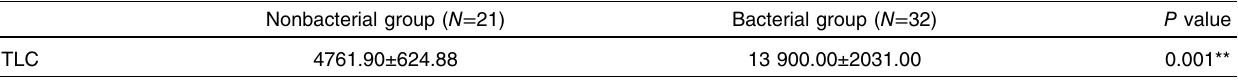
Table 11 Comparison between mean values of TLC in the two studied groups Nonbacterial group ( N = 21) Bacterial group ( N = 32) P value TLC 4761.90±624.88 13 900.00±2031.00 0.001** TLC, total leukocyte count. ** P < 0.01 = highly significant.